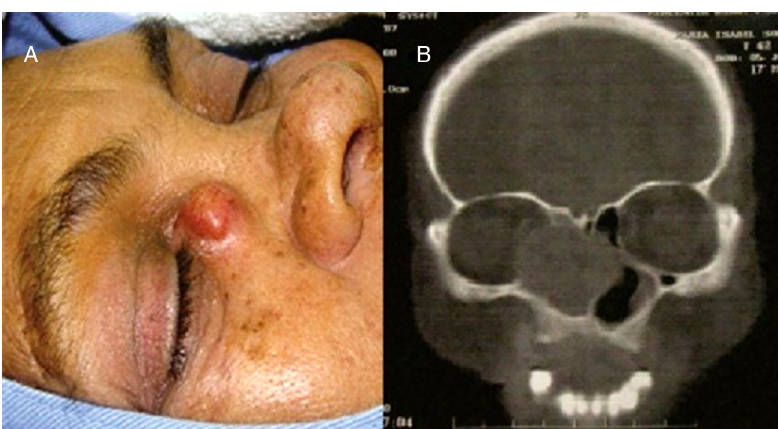
Figure 1 (A) Macroscopic aspect of the lesion in the medial region to the eyeball. (B) Computed tomography of the paranasal sinuses, coronal